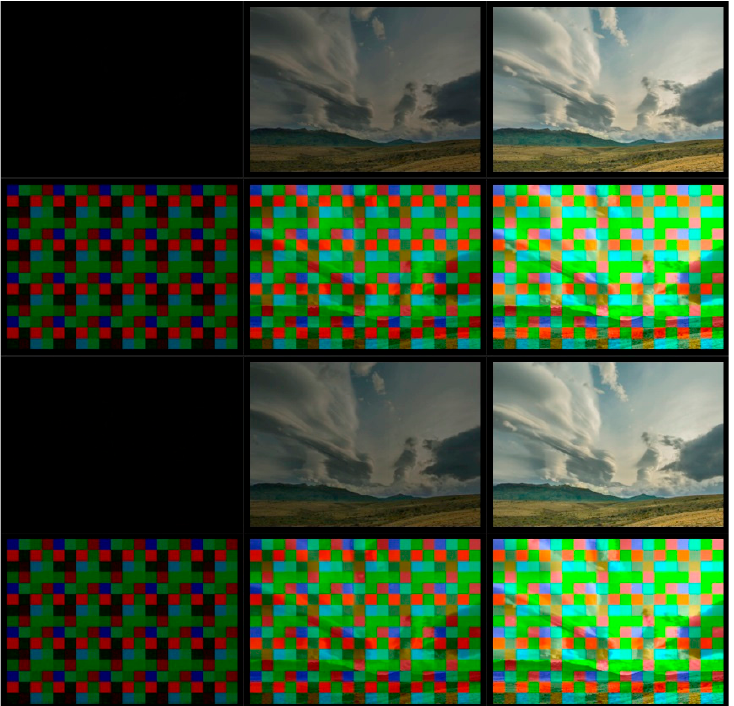
Figure 7. Preview of the results of watermark embedding and extraction under CRF = 20 compression conditions for: 1, 15, and 30 frame of test video for a 480 × 640 video fragment encoded with a 128 × 128 encoder (viewed from the left, the columns represent consecutive video frames, viewed from the top, the consecutive rows represent the original image, the watermark image, the watermarked image, and the recovered